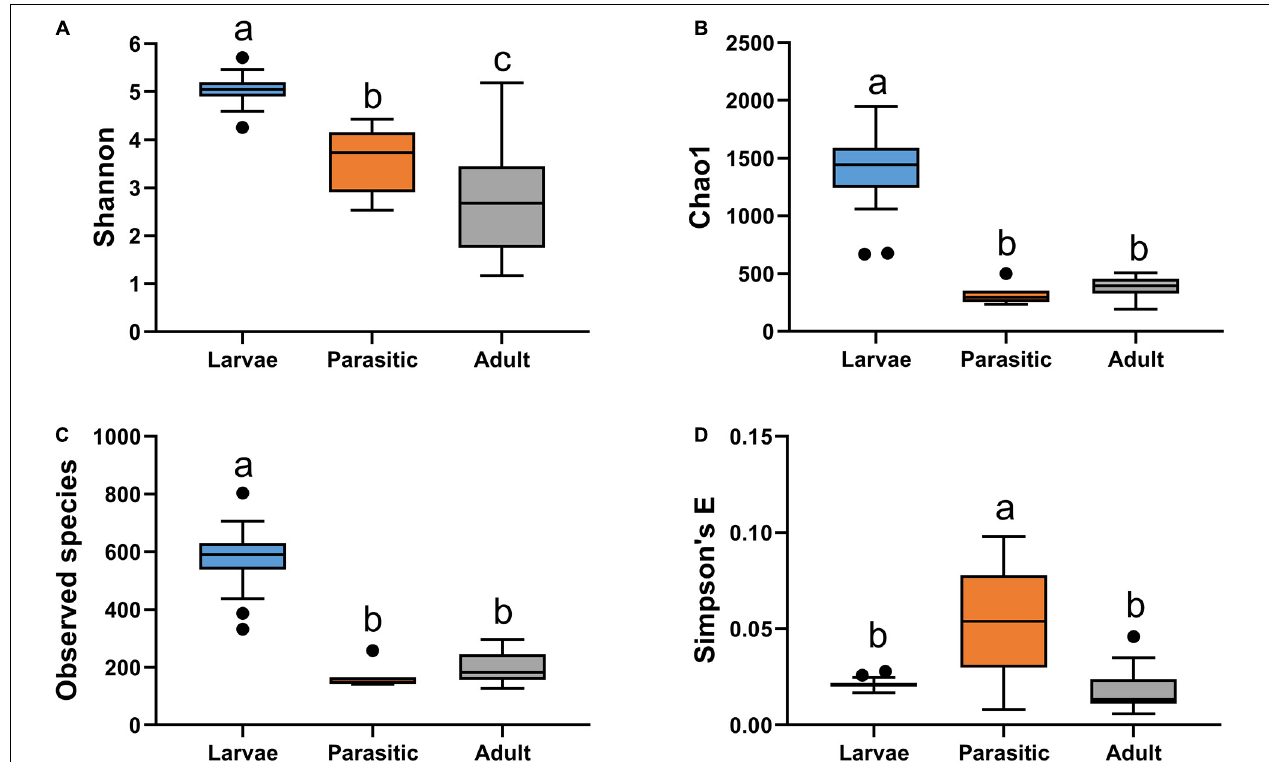
FIGURE 2 | Alpha diversity analysis of microbial communities associated with larval, parasitic, and adult sea lamprey ( Petromyzon marinus ): (A) Shannon, (B) observed species, (C) Chao1, and (D) Simpson’s E. Tukey’s HSD post hoc test. On the boxplots, the centerlines show the medians, the bottom and upper limits indicate the 25th and 75th percentiles and the whiskers encompass the 10–90 percentile range; significant differences ( p < 0.05) illustrated by different letters above bars.